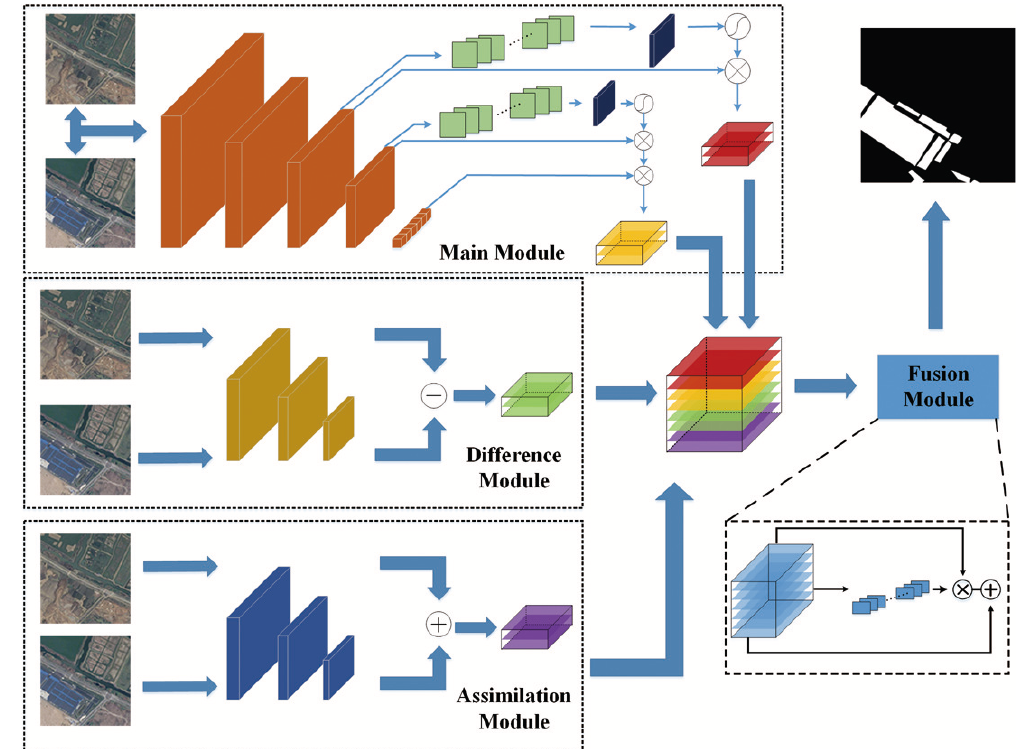
Figure 1. Trilateral change detection network (TCDNet) framework. The model consists of four parts: main module, difference module, assimilation module, and fusion